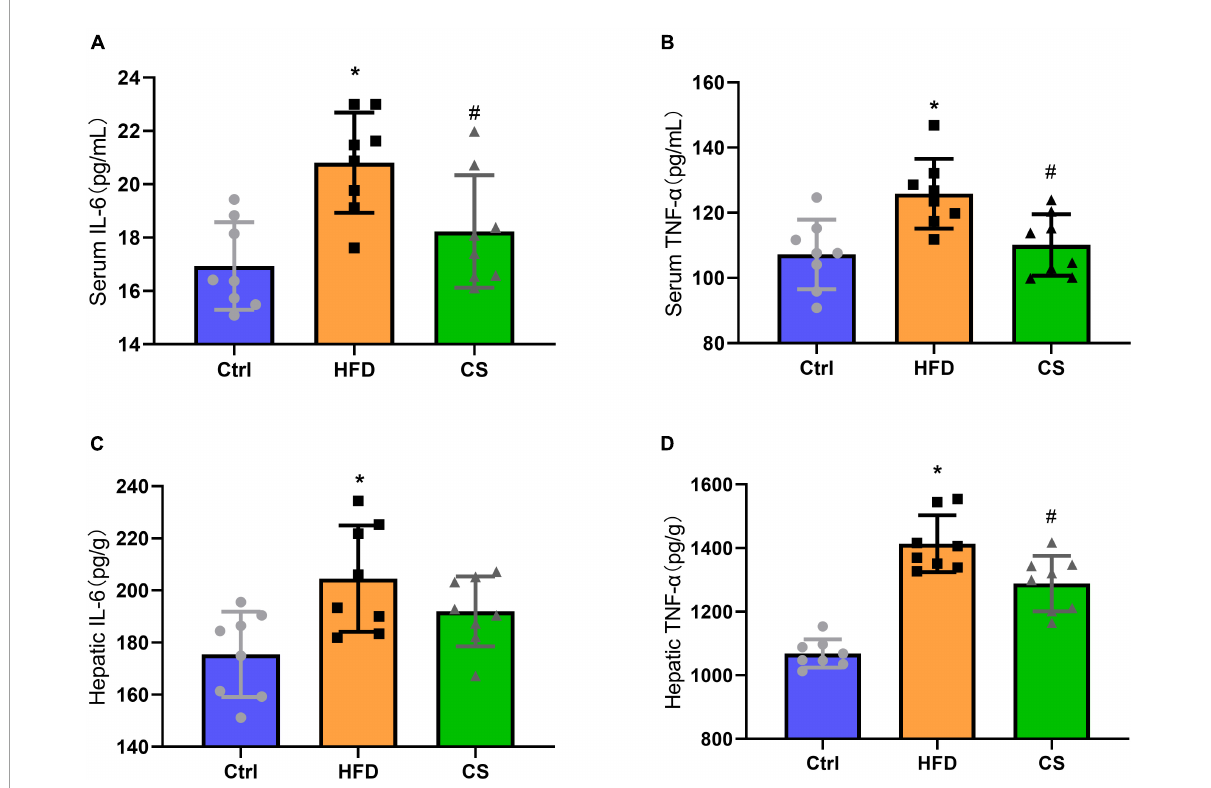
FIGURE5 Effects of corn silk extract on chronic inflammation. (A) Serum IL-6; (B) serum TNF- α ; (C) hepatic IL-6; (D) hepatic TNF- α . Control diet (Ctrl) group, high- fat diet (HFD) group, corn silk (CS) group. The results are means ± SD ( n = 8). * p < 0.05 vs. Ctrl, # p < 0.05 vs.